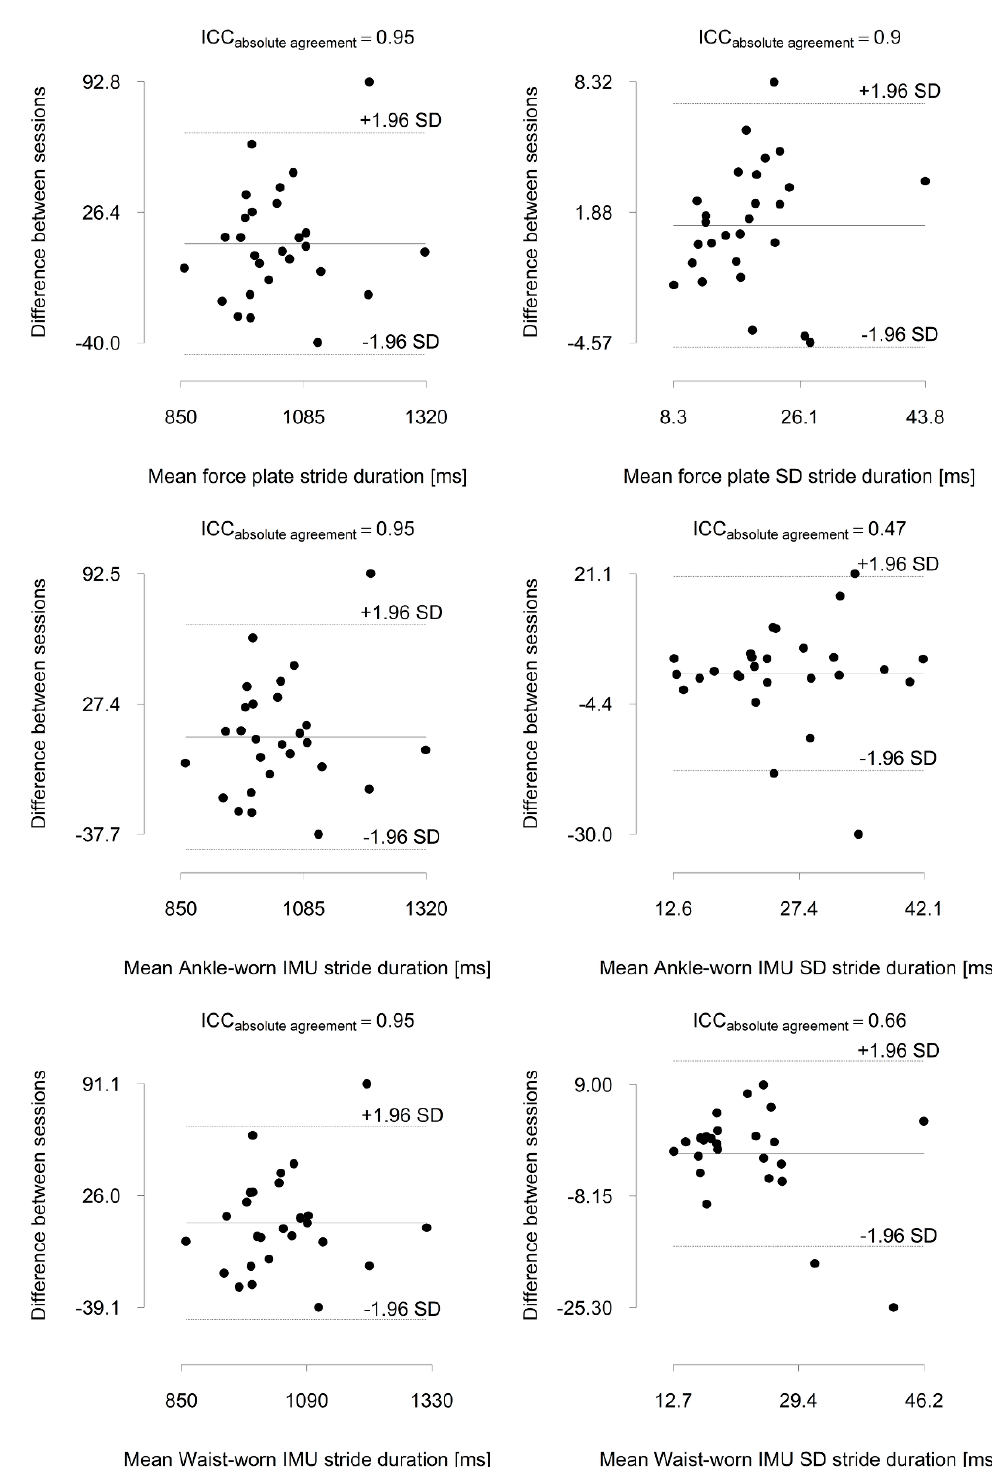
Figure 2. Bland-Altman plots of stride duration and stride duration variability assessed a week apart with a force plate and a wait-worn and ankle-worn inertial measurement unit (IMU). ICC = intra-class correlation coefficient.